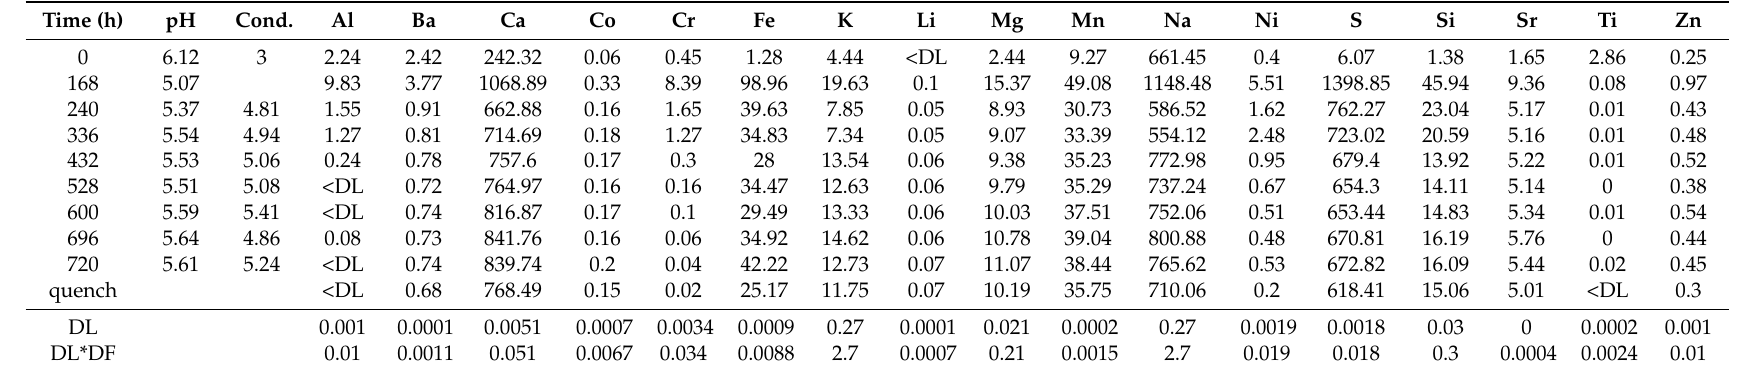
Table 3. Solution pH and conductivity (ms/cm) during the cap-rock reaction, note this was measured ex situ immediately on sampling. Dissolved element concentrations (mg/kg), and the associated detection limit (DL) and effective detection limit multiplied by the dilution factor (DL*DF). <DL indicated the measurement was below detection. Time zero refers to the sample after the N 2 -water-rock soak. Quench refers to the residual fluid in the reactor after depressurization. The associated error for the analyses by ICP-OES is